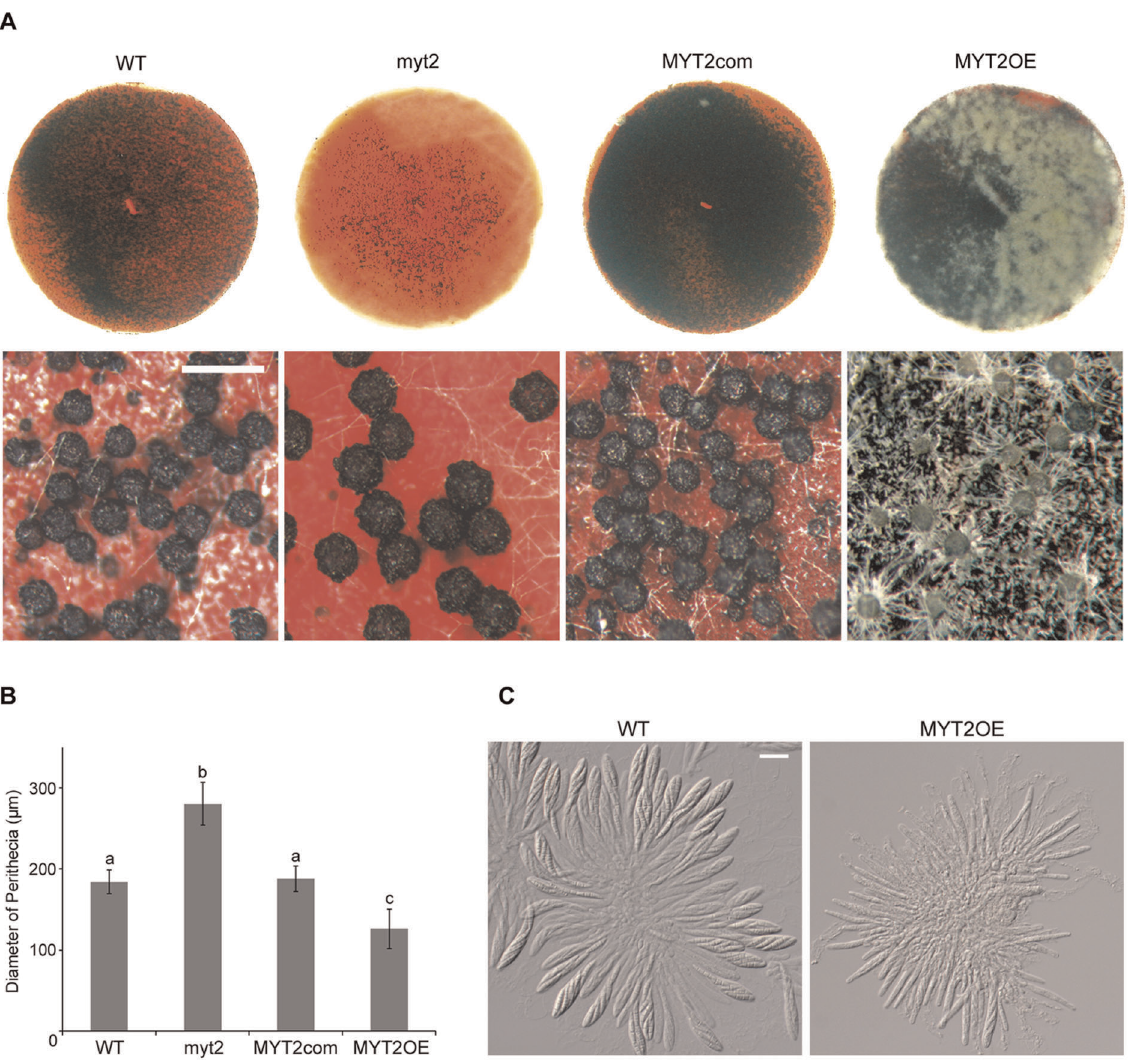
Figure 3. Self-fertility and asci rosettes of the G.zeae strains. (A) Perithecia of the G. zeae strains. Five-day old carrot agar culture was mock- fertilized to induce sexual reproduction and incubated for an additional 7 d. The upper and lower panels show the photographs of perithecia formed on a whole carrot agar plate and the photographs taken with a dissecting microscope, respectively. Scale bar =200 m m. (B) Diameter of the perithecia of the G. zeae strains. The diameters of 300 perithecia were measured for each strain using a dissecting microscope. Values with different letters are significantly different ( p , 0.05) based on Tukey’s test. (C) Asci rosettes of wild-type and MYT2 overexpression strains. Perithecia were dissected seven days after sexual induction. Scale bar =20 m m. WT, G. zeae wild-type strain Z-3639; myt2, MYT2 deletion mutant; MYT2com, myt2 - derived strain complemented with MYT2 ; MYT2OE, transgenic strain that has the EF1 a promoter in place of the MYT2 promoter region.